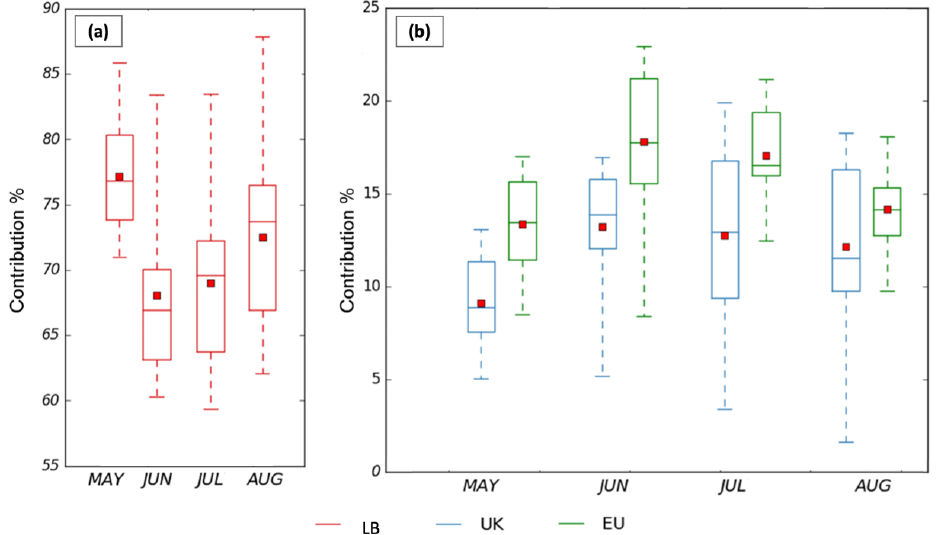
Figure 3. Monthly relative contributions (%) to surface O 3 in the UK from May to August 2015 from (a) the lateral boundaries (LB) and (b) the UK and the Eu super-region. The lower and upper end of the boxes indicate the 25th and 75th percentiles, the central bar the median, and the red square the mean. Whiskers indicate the maximum and minimum. Note the differences in the scale in the y